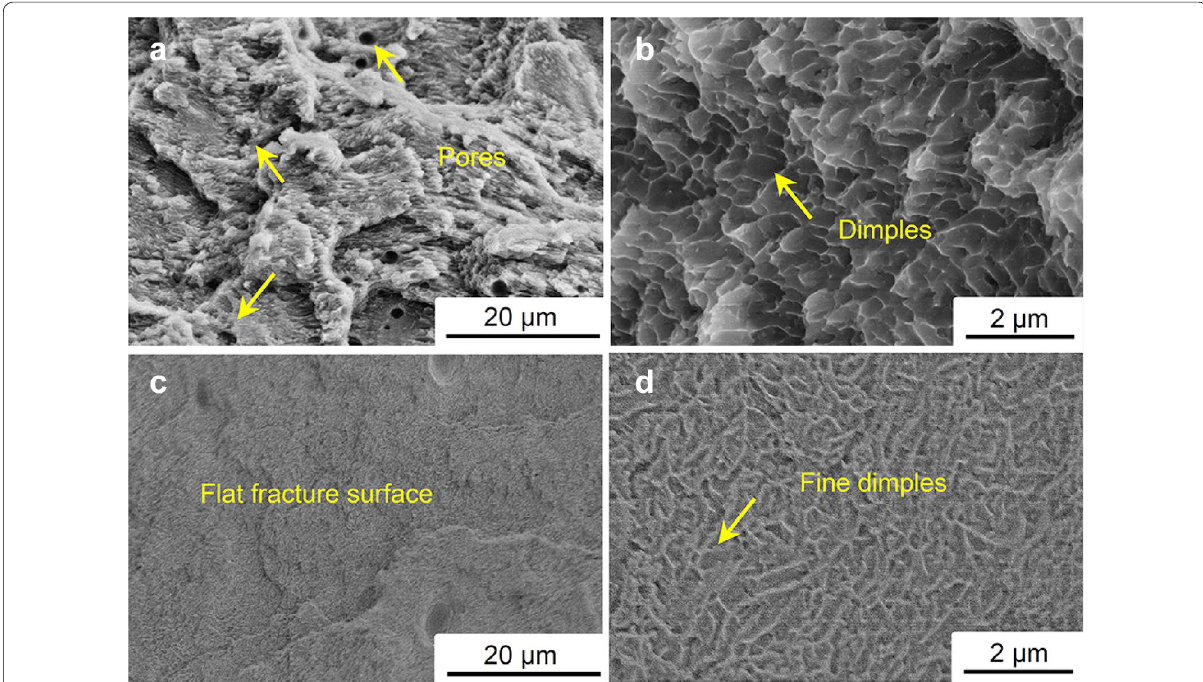
Figure 11 Typical FE-SEM fracture morphologies taken from the tensile fracture surface of samples at room temperature tensile test: low magnification a AlSi10Mg and c